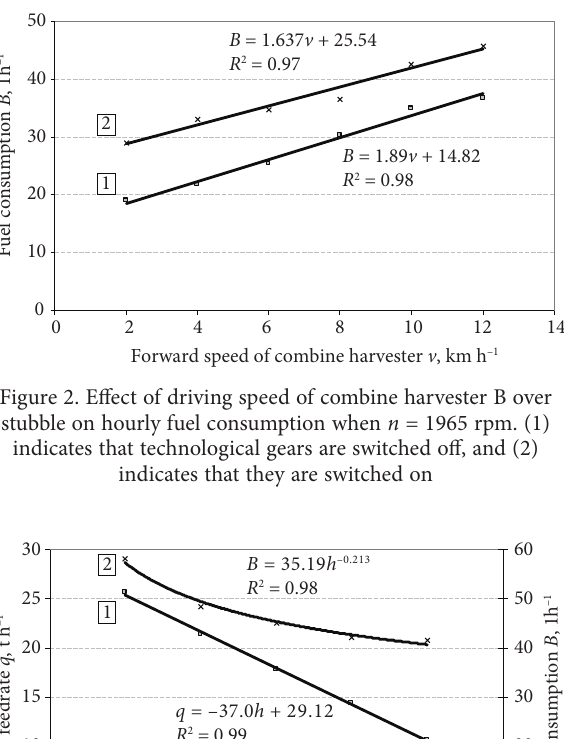
B = 1.637 v + 25.54 R 2 = 0.97